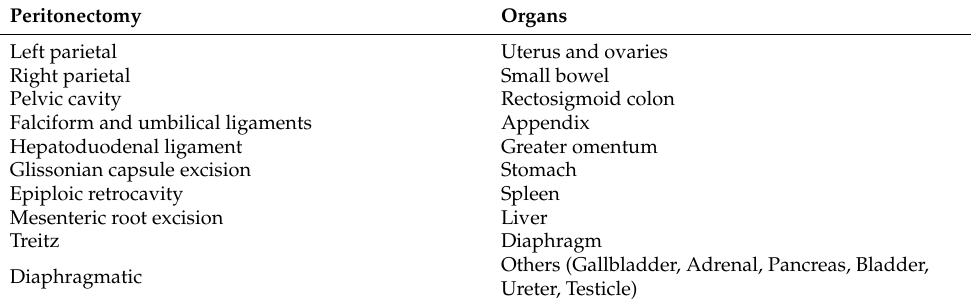
Table 1. Listing of resected regions and